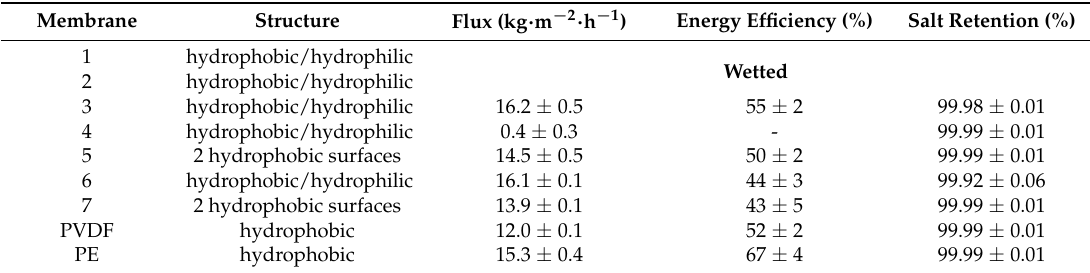
Table 7. Flux, energy efficiency and salt retention. Process conditions: T f = 60 ◦ C, T p = 45 ◦